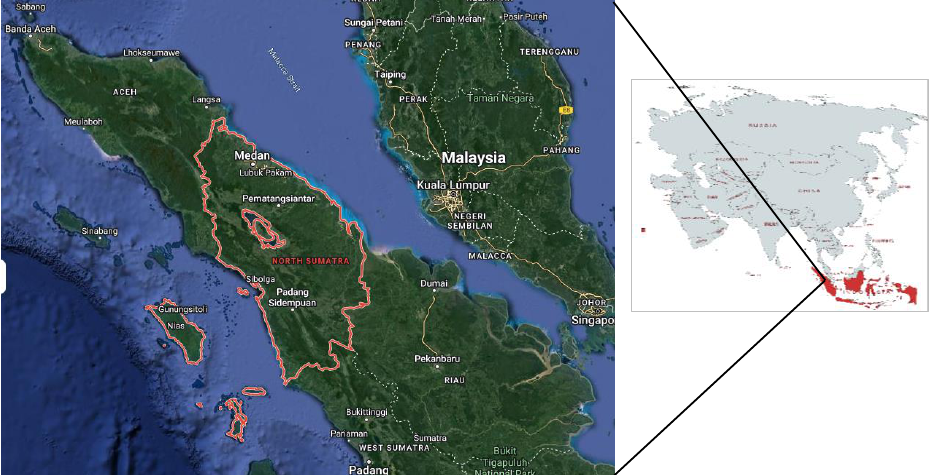
Figure 1. Map of North Sumatra, Indonesia